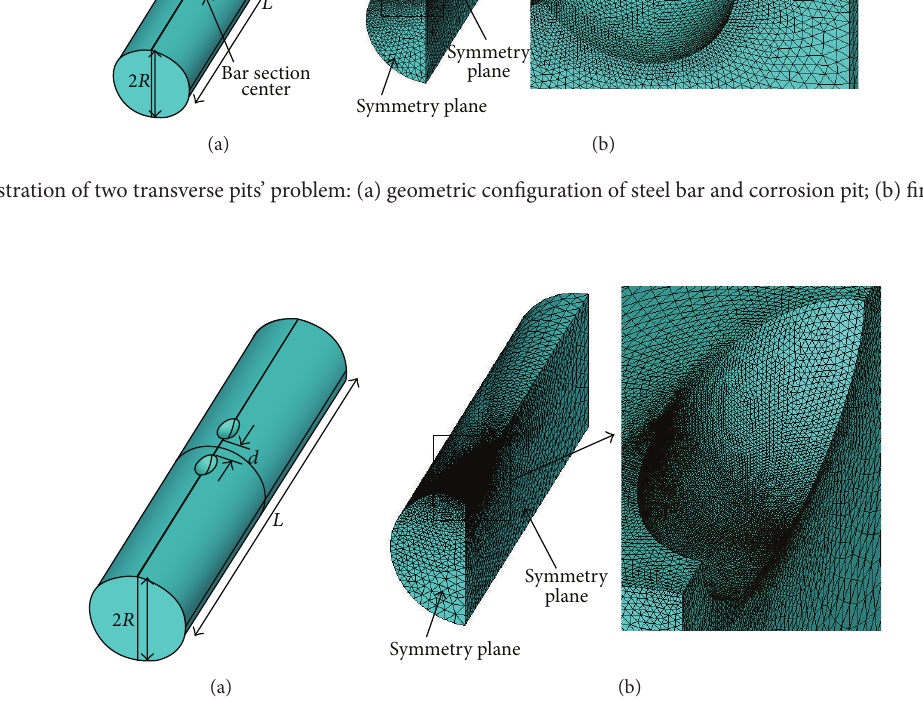
region is convergent; the SCF for various mesh numbers